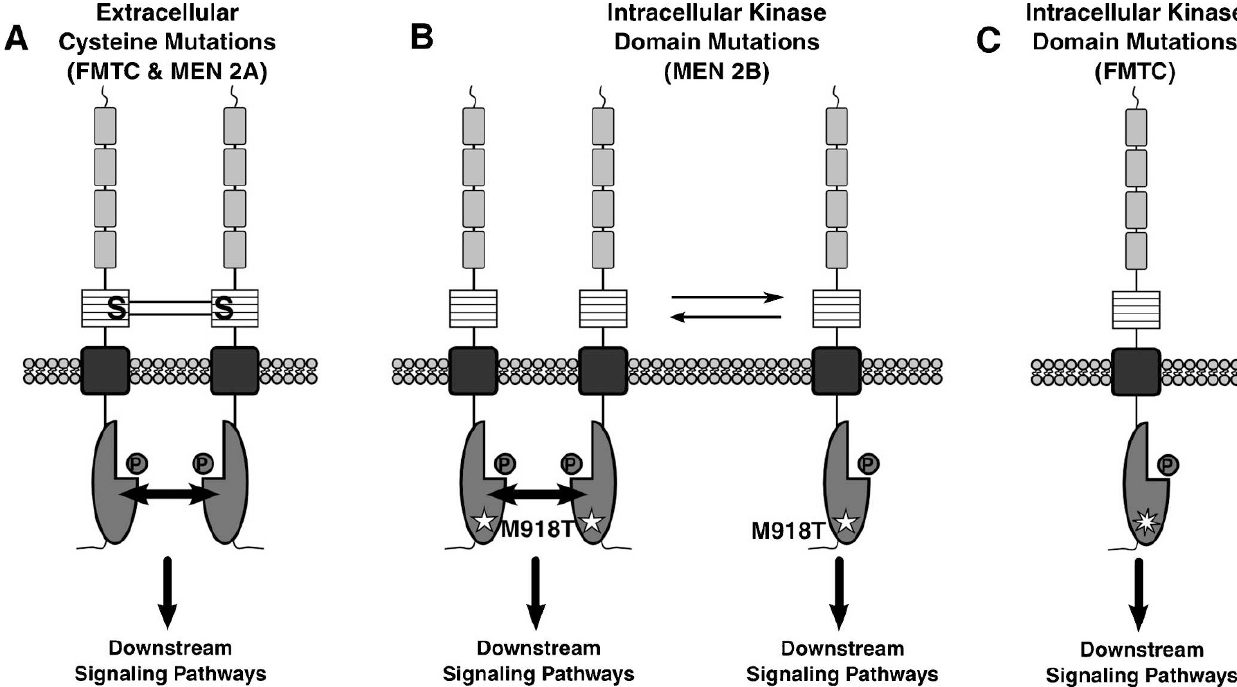
Figure 2 - Molecular mechanisms of pathogenic RET activation. Schematic diagrams showing mechanisms of RET activation in the presence of various multiple endocrine neoplasia type 2 (MEN 2) mutations. (A) Substitutions of extracellular cysteines lead to formation of intermolecular disulfide bonds and to constitutive RET dimerization and activation. (B) The MEN 2B mutation, M918T (star) in the kinase domain, leads to a conformational change with multiple effects including an increase in RET kinase activity and activation of receptors in either dimeric or monomeric form. (C) Intracellular kinase domain mutations asterisk implicated in familial medullary thyroid carcinoma (FMTC) (e.g. residues 791 and 891), permit activation of monomeric RET, allowing for a partially